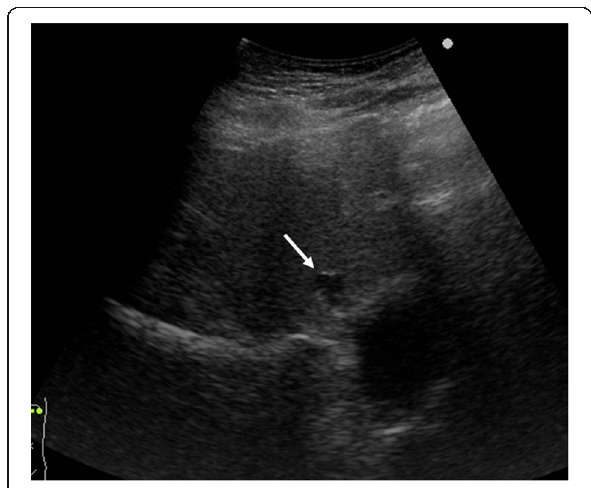
Fig. 4 Postoperative abdominal ultrasonography findings. The abscess (white arrow) became